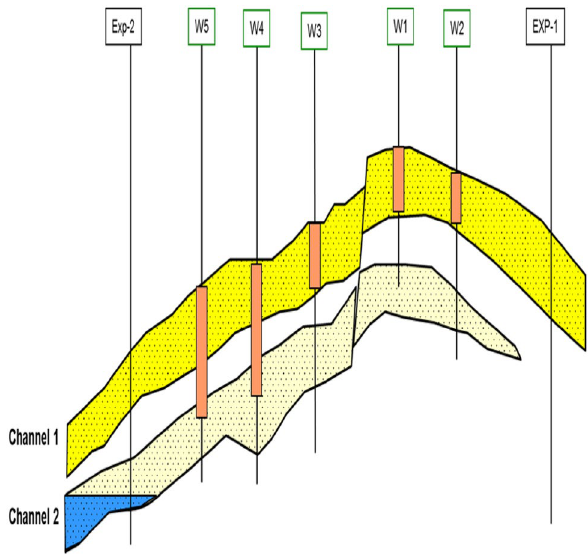
Fig. 3 Schematic of field case 1 wells